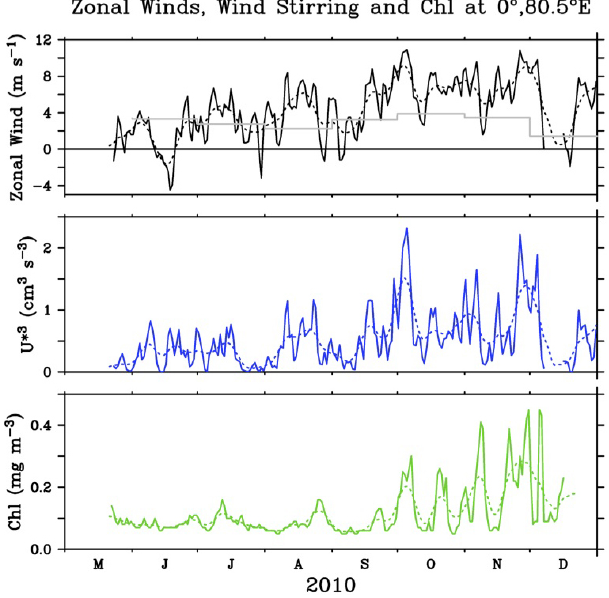
Figure 8. A closer look at winds and chlorophyll at the mooring location. Top panel is daily average zonal wind speed (ms − 1 ; solid black line) overplotted on climatological monthly mean wind speed (grey line). Middle panel is daily average friction velocity cubed (cm 3 s − 3 ), which is a measure of wind-induced turbulence genera- tion (“wind stirring”) in the mixed layer. Friction velocity is defined as | τ / ρ 0 | 1 / 2 , where τ is surface wind stress magnitude and ρ 0 is the density of sea water. Bottom panel is the daily average of mooring chlorophyll fluorescence measurements (mgm − 3 ). Dashed lines are daily data smoothed with a moving 13-day triangle filter, which is equivalent to a weekly